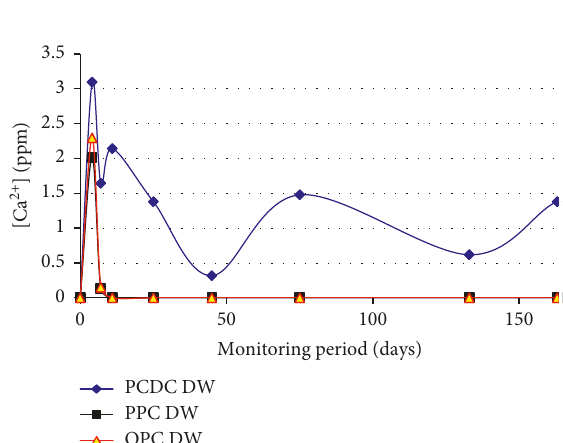
Figure 14: SO 42